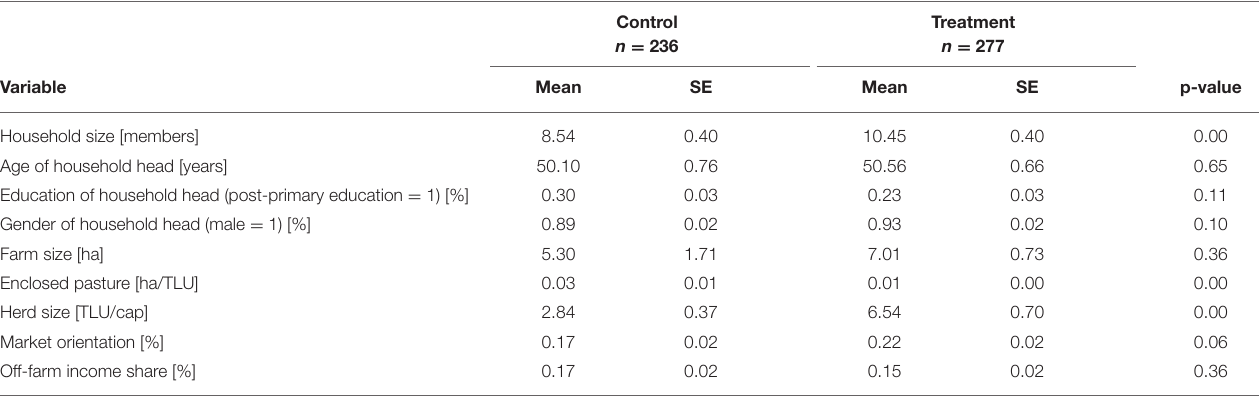
TABLE 3 | Descriptive statistics of independent variables for ITM treatment and control